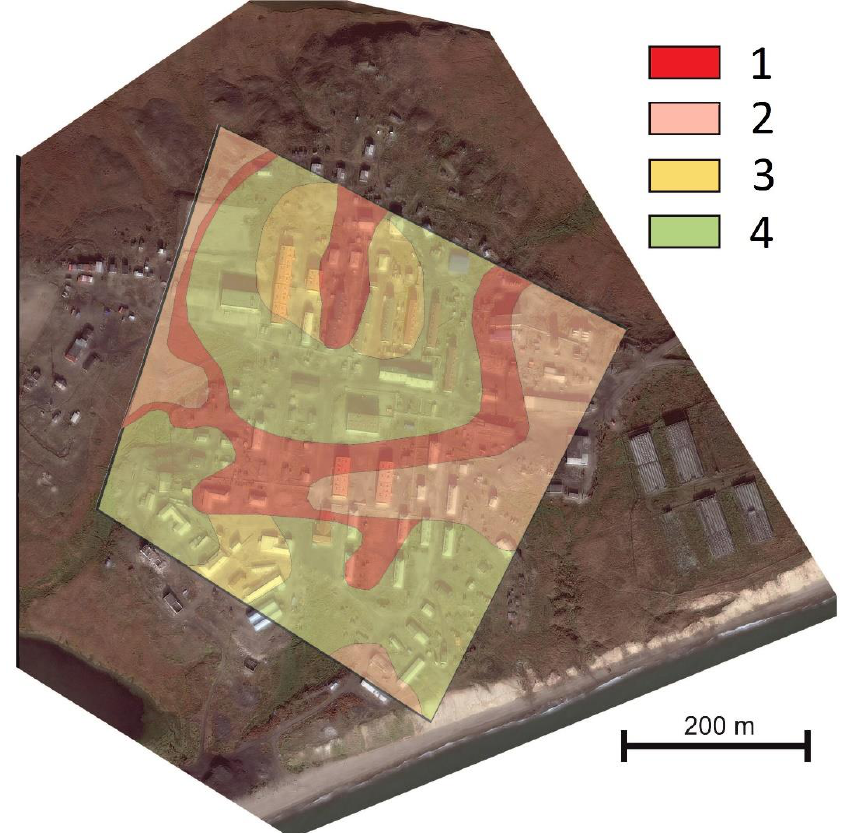
Figure 6. Classification of cryogenic hazards in the built-up area of Lorino. Key: ( 1 ) areas of active thermokarst and thermoerosion; ( 2 ) areas of unstable ice-rich permafrost and frost-susceptible sediments; ( 3 ) areas of stable permafrost and thermokarst of Layer B; ( 4 ) areas of stable coarse-grained drained sediments and